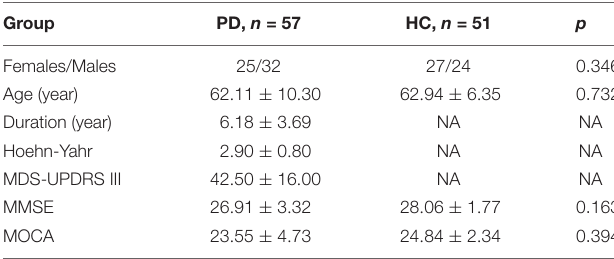
PD, Parkinson’s Disease; HC, Healthy Controls; MMSE, Mini-mental State Examination; MOCA, Montreal Cognitive Assessment; MDS-UPDRS III, Movement Disorder Society Unified Parkinson’s Disease Rating Scale Part III. Data are represented as mean ± SD.